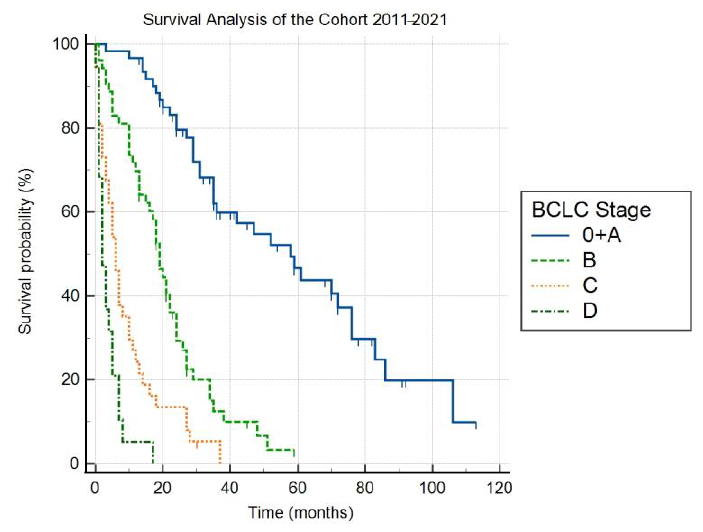
Figure 1. Survival Analysis of the Cohort 2011–2021.